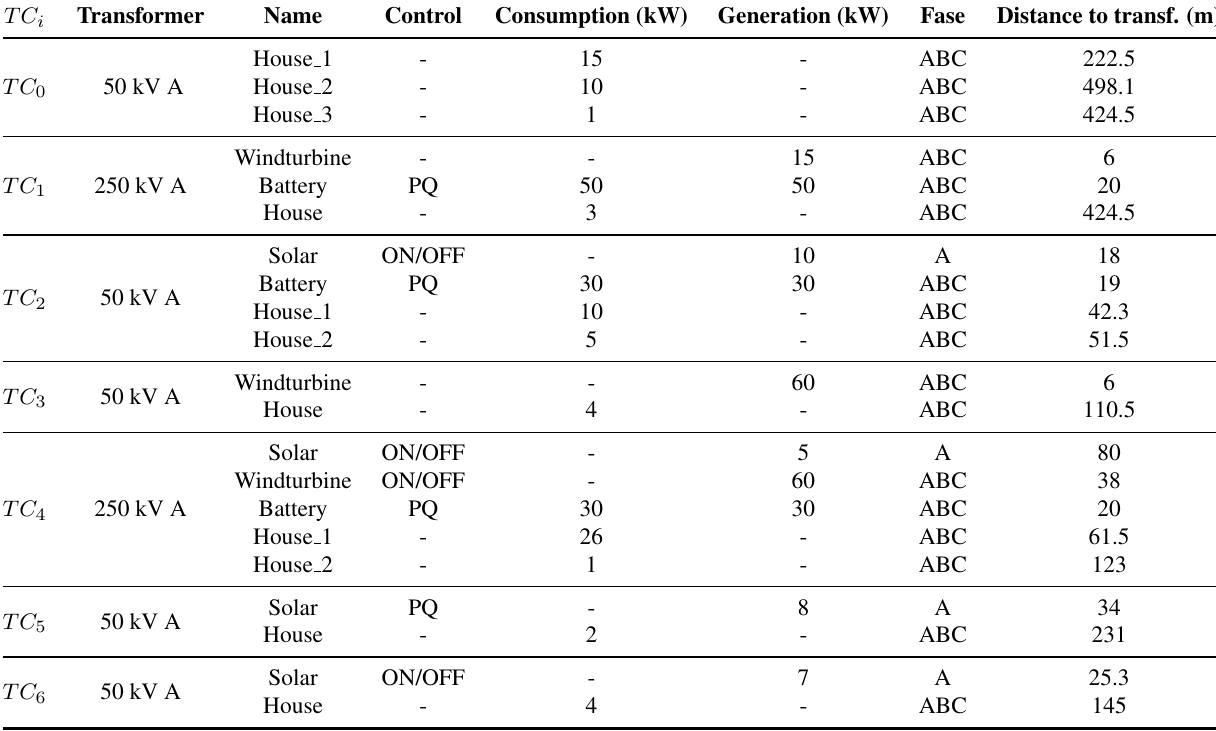
Table 1. Elements